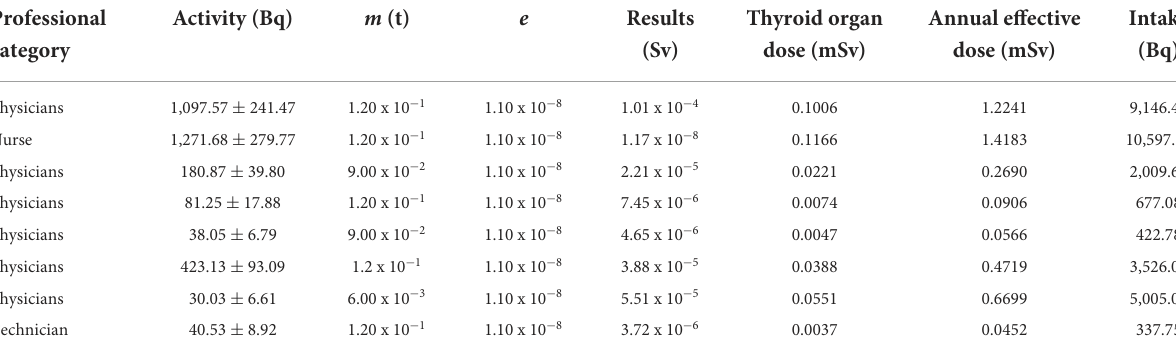
TABLE 4 Estimate of internal thyroid 131 I dose in 2019.